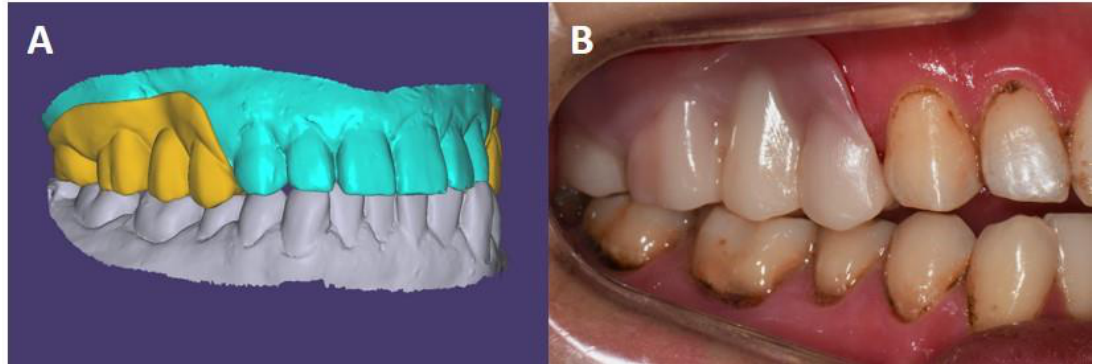
Figure 3. Fabrication of interim prosthesis. ( A ), The prosthesis was designed with CAD software (Exocad). ( B ), Clinical photo of the prosthesis. The margins of denture flange were adjusted during the follow-up period.